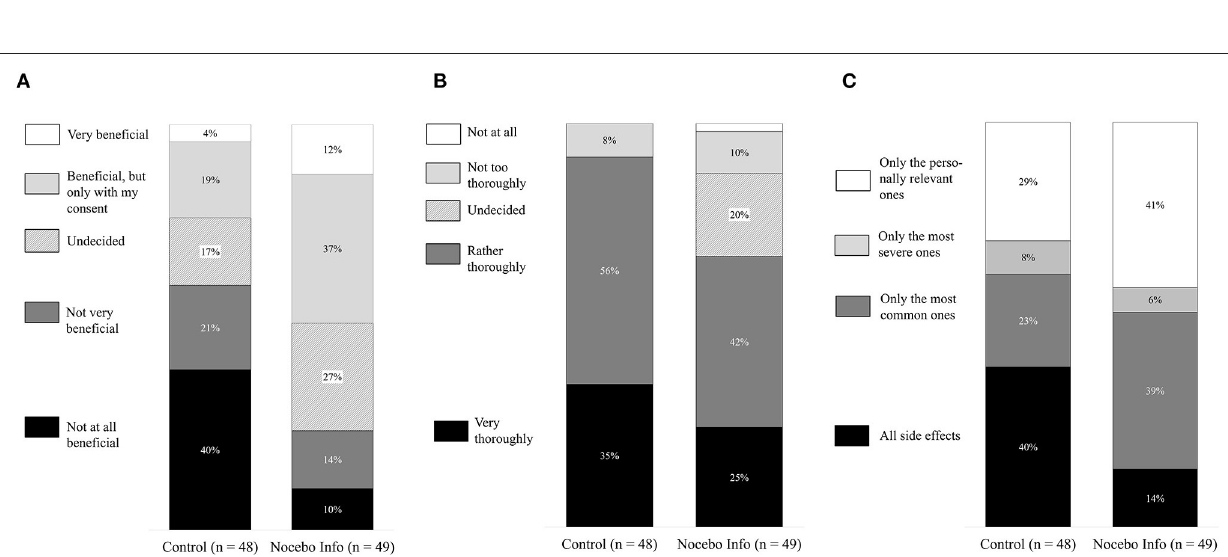
FIGURE 2 | Satisfaction with information about medication at prescription. Percentages indicate the proportion of patients agreeing to each item (scores #3–5) ( N = 97).